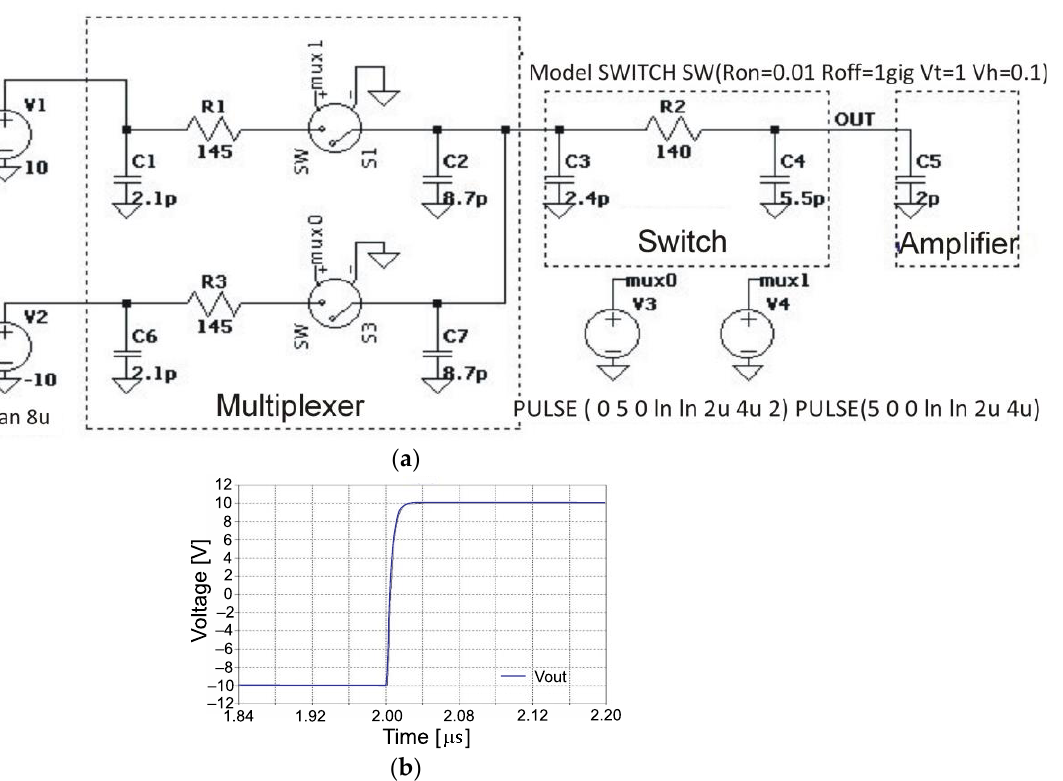
Figure 5. Multiplexer setting time simulation scheme ( a ); switch output setting simulated in LTSpice ( b ).